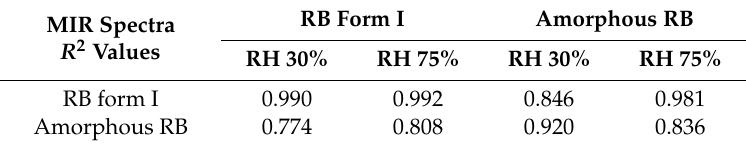
Table 1. Correlation values among amorphous RB form I and prepared RB samples. MIR